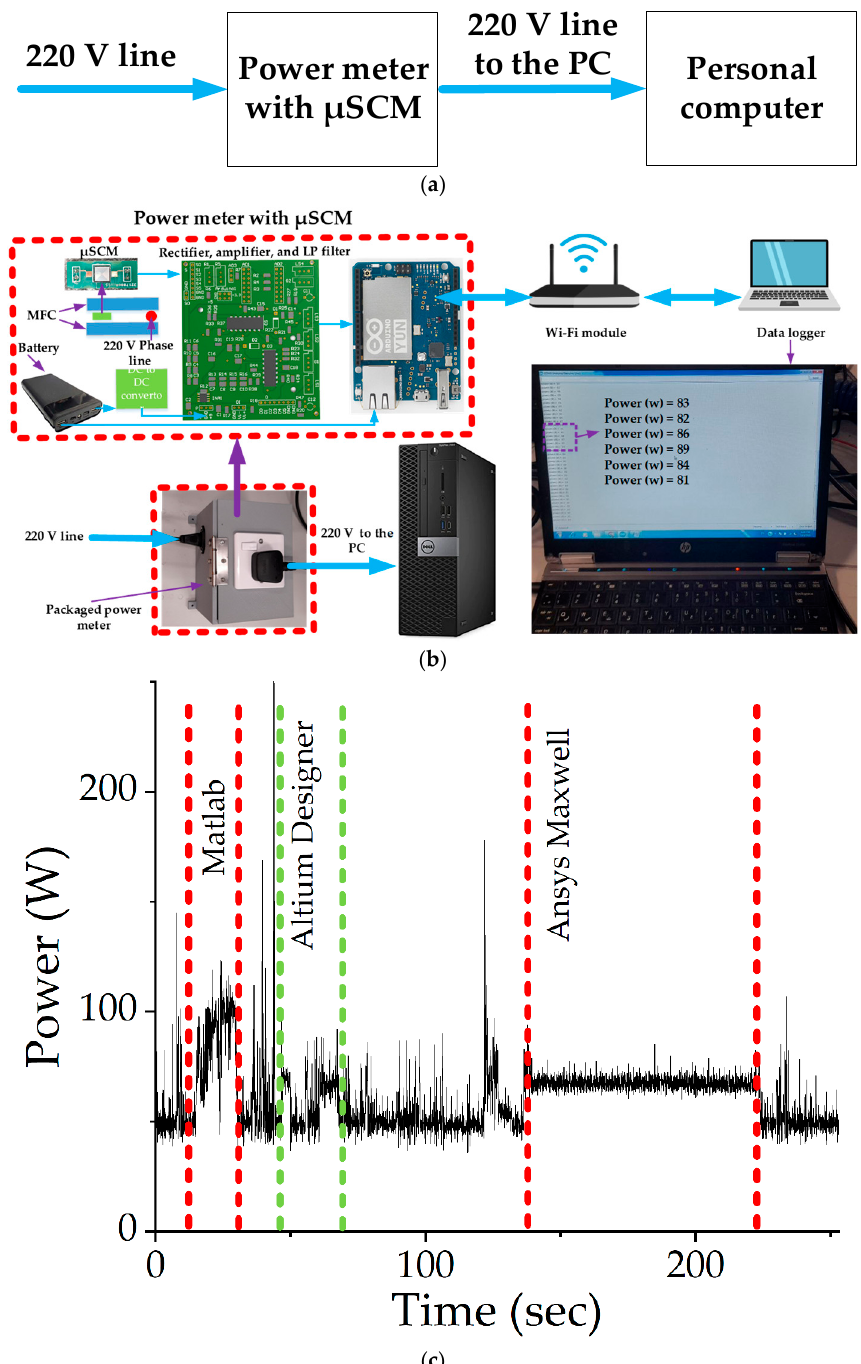
Figure 9. ( a ) The block diagram of the power measurement setup. ( b ) A personal computer power measurement setup with its required components. ( c ) The power of a PC as a function of time using a packaged µ SCM shows the sensor data can be used to identify different operation modes: an idle mode and different running programs (MATLAB, Altium Designer, ANSYS Maxwell,